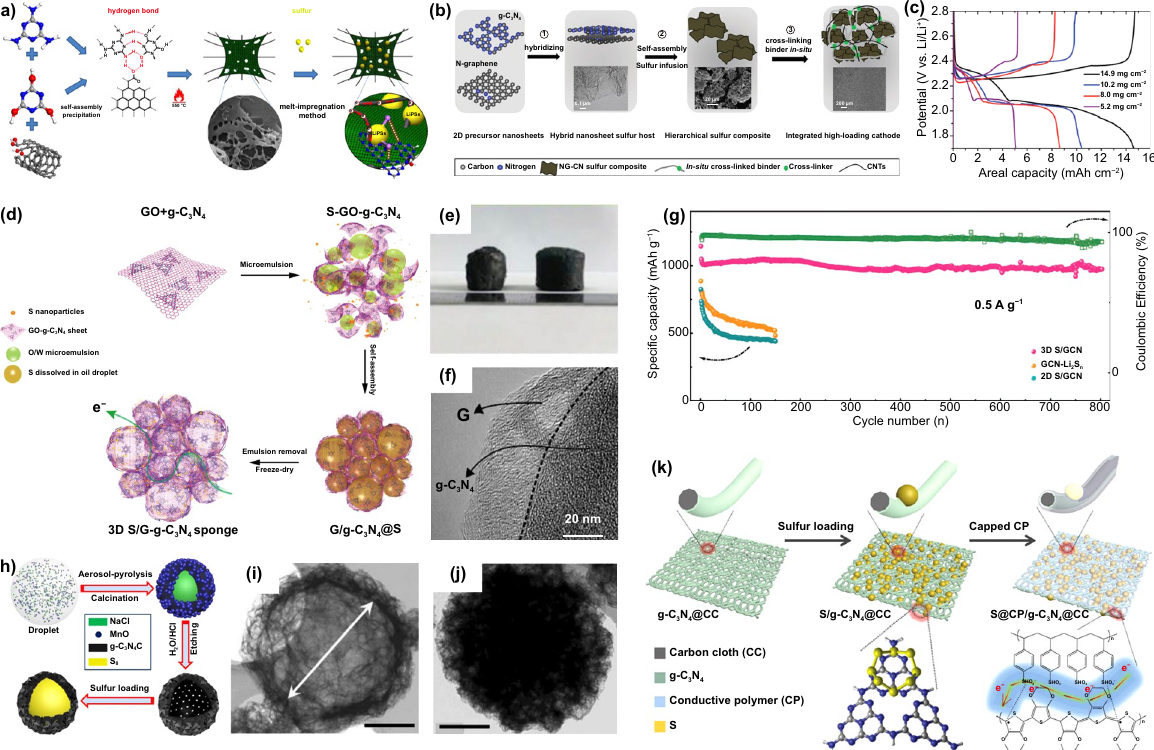
Fig. 7 a Schematic illustration of the preparation process of S/CN‑CNTs composite [33]. Copyright 2019, American Chemical Society. b Sche‑ matic illustration of the preparation process of NG‑CN/CMC‑CA/S composite. c Charge–discharge voltage profiles of cells using NG‑CN/CMC‑ CA/S cathodes with different sulfur loadings at 0.5 mA cm −2 [42]. Copyright 2016, Wiley–VCH. d Schematic illustration of the preparation process of S/GCN hybrid sponge. e Optical images of G‑sponge (left) and S/GCN hybrid sponge (right). f TEM image of S/GCN. g Cycling performance of 3D S/GCN, GCN‑Li 2 S n and 2D S‑GCN cathodes at 0.5 A g −1 [32]. Copyright 2018, Wiley–VCH. h Schematic illustration of the preparation process of the S@C 3 N 4 /C microsphere. TEM images of i PC‑C 3 N 4 /C and j S@C 3 N 4 /C [88]. Copyright 2020, Elsevier. k Schematic illustration of the preparation process of S@CP/g‑C 3 N 4 @CC composite material [41]. Copyright 2020,